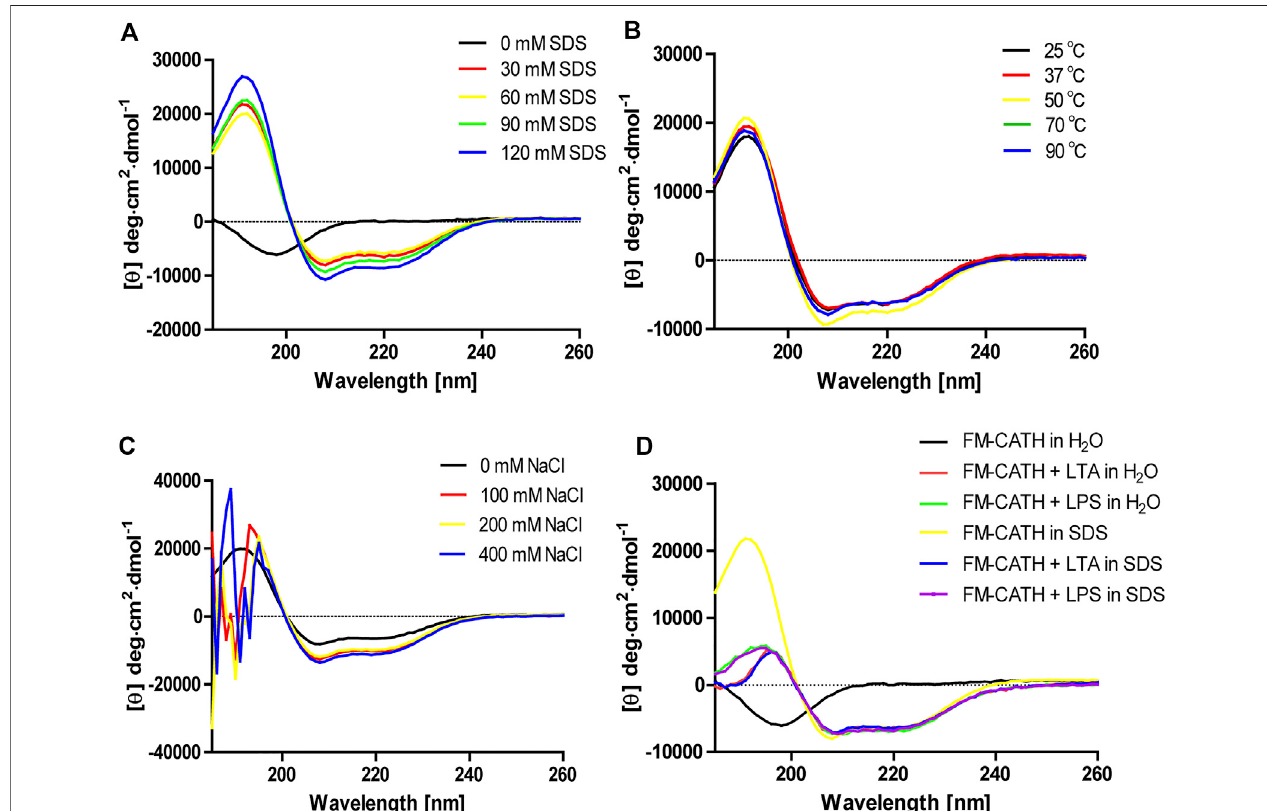
FIGURE 2 | CD analysis ofFM-CATH in (A) membrane-like SDS solutions, (B) 60 mM SDS solution under different temperatures, (C) various NaCl concentrations or (D) the aqueous solution or 30 mM SDS solution containing LPS or LTA for 1 h before CD spectra measurement.